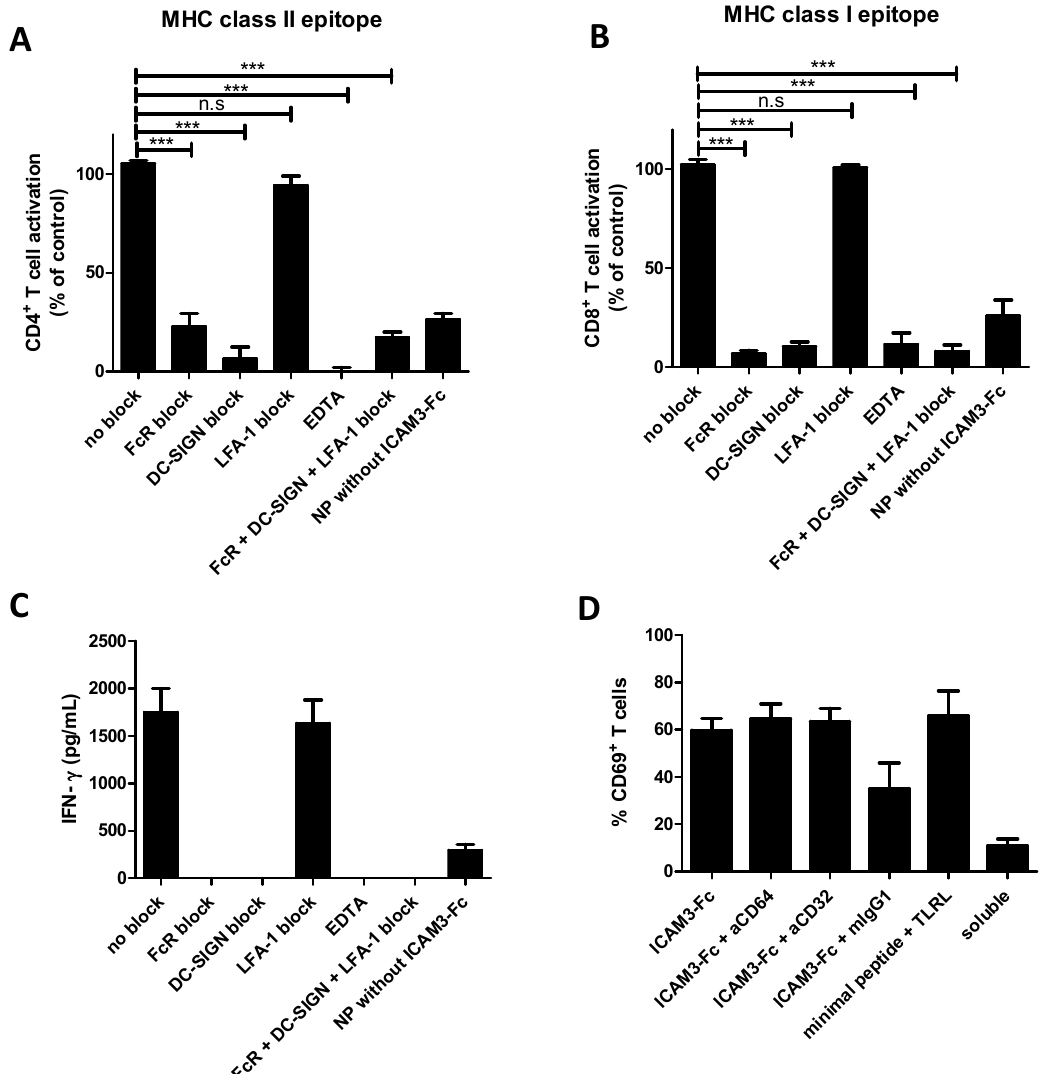
Figure 5. Antigen presentation by DCs following ICAM3-Fc targeted NP vaccines requires DC-SIGN binding and is blocked by excess IgG. ( A ) DCs were cultured in the presence of NP vaccines carrying the MHC class-II restricted specific TT peptide. Uncoated NP vaccine (NP without ICAM3-Fc), ICAM3-Fc-coated NP vaccine (no block, positive control) or a combination of ICAM3-Fc-coated NP vaccine and excess human IgG (FcR block), DC-SIGN-specific antibodies (DC-SIGN block), LFA-1 blocking antibody (LFA-1 block), EDTA or FcR block + DC-SIGN block + LFA-1 block (FcR + DC-SIGN + LFA-1 block). Subsequently, DCs were cultured with TT-responsive PBLs and T cell proliferation was measured by tritium thymidine incorporation assay. T cell proliferation is given as a percentage of T cell proliferation of the positive control (no block). Specific T cells. Data represent mean values ± SD of 3 experiments performed in triplicate, using cell from unrelated donors. ( B , C ) DCs were cultured in the presence of NP vaccines carrying the MHC class-I restricted gp100 (272–300) peptide. Uncoated NP vaccine (NPs without ICAM3-Fc), ICAM3-Fc-coated NP vaccine (positive control) or a combination of ICAM3-Fc-coated NP vaccine and excess human IgG (FcR block), DC-SIGN-specific antibodies (DC-SIGN block), LFA-1 blocking antibody (LFA-1 block), EDTA or FcR block + DC-SIGN block + LFA-1 block (FcR + DC-SIGN + LFA-1 block). Subsequently, DCs were cultured with gp100 (280–288-specific naïve CD8 + T cells). Data represent mean values ± SD of 3 experiments performed in triplicate, using cell from unrelated donors. Untreated DCs and DCs cultured with soluble gp100 (272–300) peptide and TLRLs (soluble) served as controls. Next, DCs were co-cultured with gp100 (280–288-specific naïve CD8 + T cells). T cell activation was determined either by measuring CD69 expression levels and given as a percentage of the positive control (no